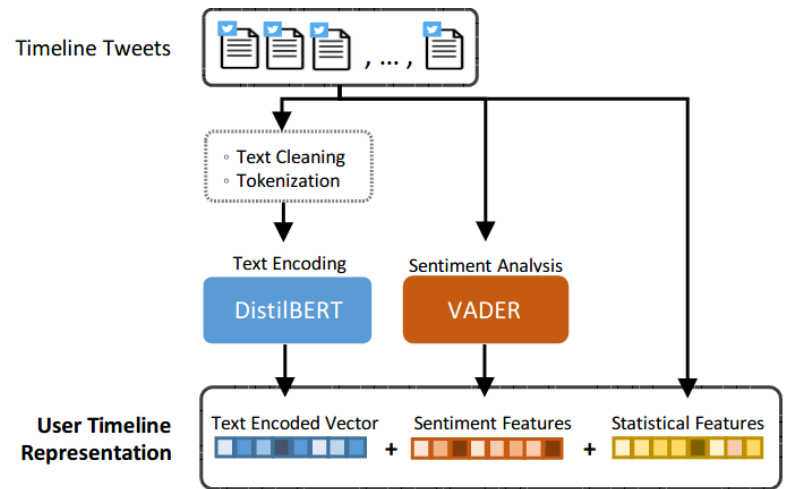
Figure 5. The architecture of user timeline